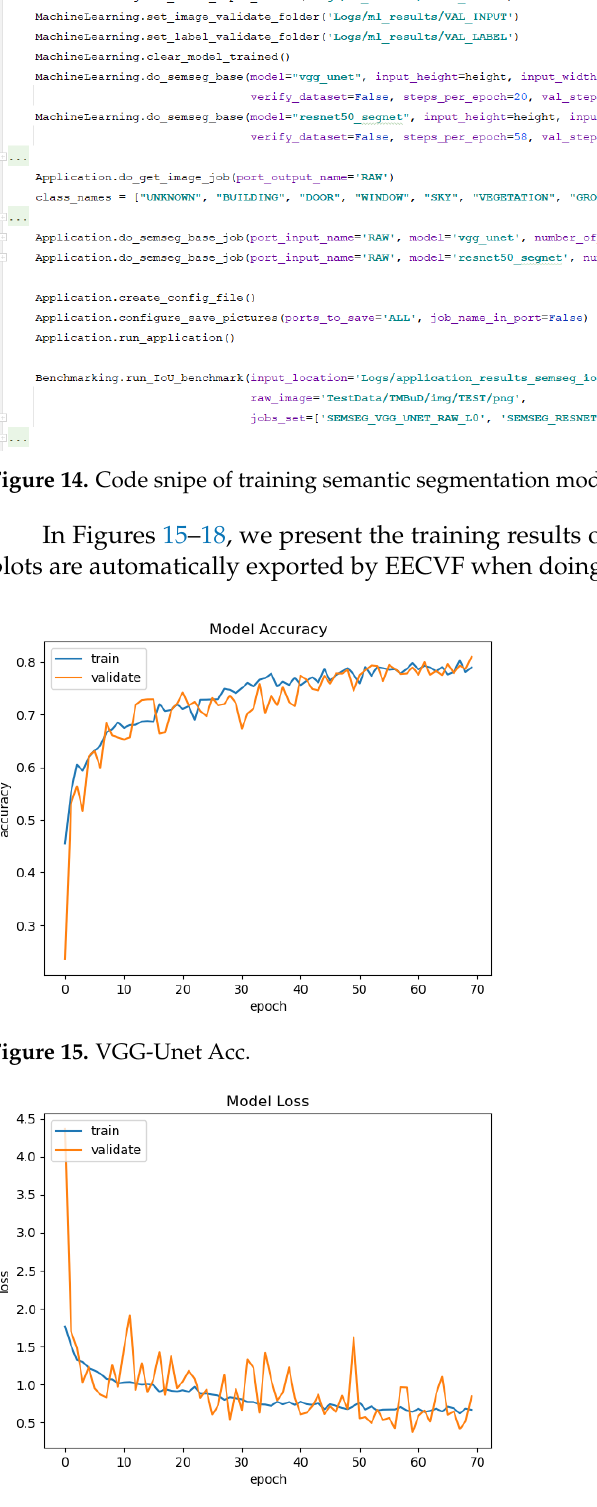
Figure 16. VGG-Unet